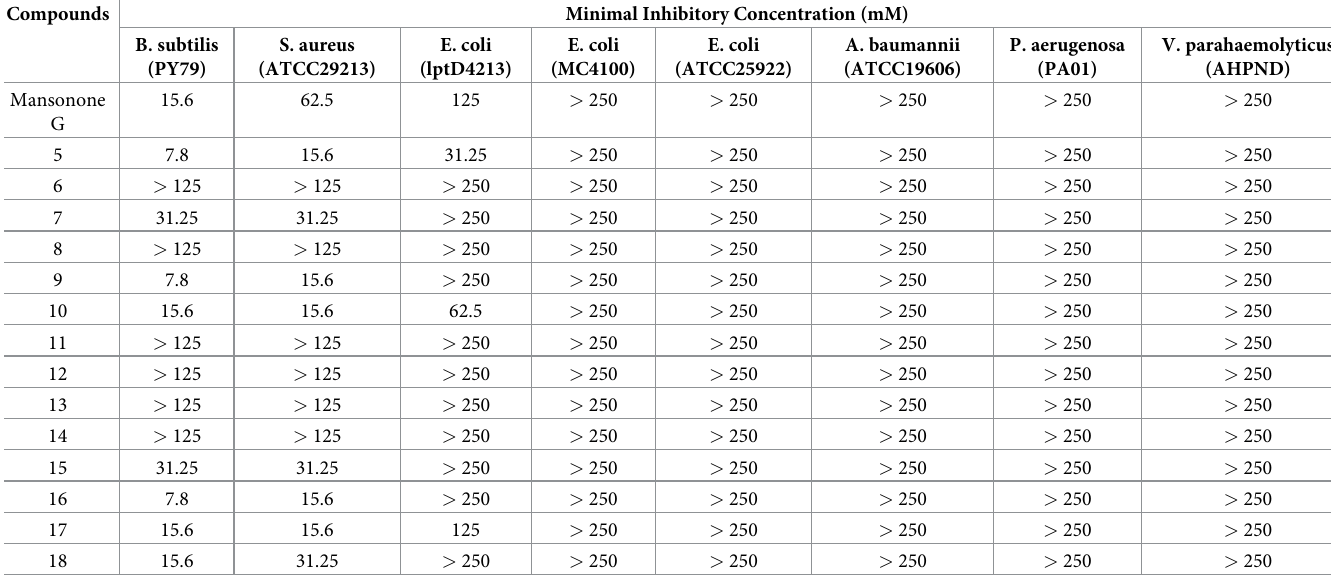
Table 1. Minimal inhibitory concentration of mansonone G and its